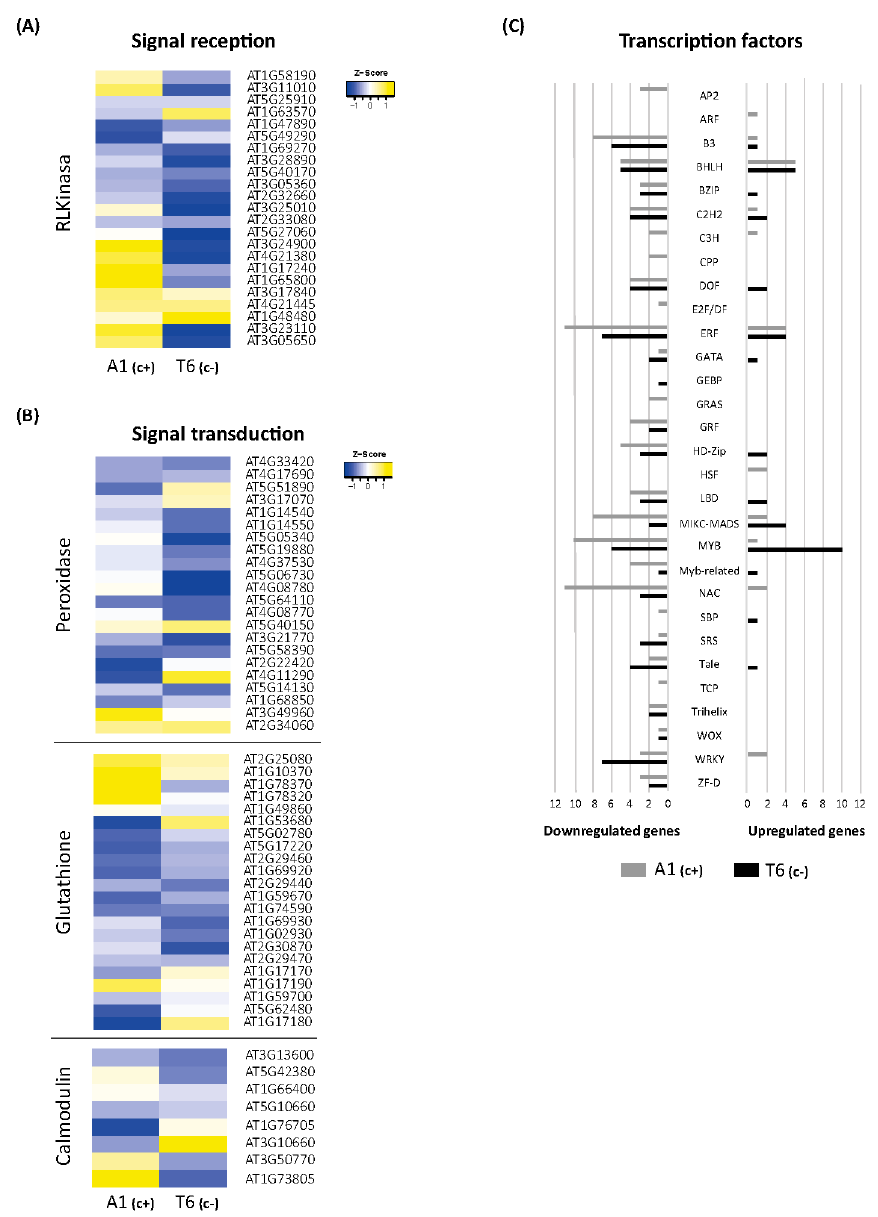
Figure 4. Differential expression of signal perception, transduction, and transcription factor (TF) genes involved in bicarbonate short responses. Heatmaps of DEGs from the receptor-like kinase gene family ( A ), and peroxidase, glutathione, and calmodulin gene families ( B ) in A1 (c+) and T6 (c+) , comparing bic vs. pH 5.9 exposure for 3 h. Yellow color represents upregulated genes while blue color represents downregulated genes. ( C ) Bar plot indicating the total number of DEGs upregulated (right) or downregulated (left) within each transcription factor family. Tolerant deme A1 (c+) is marked in grey, while sensitive deme T6 (c − ) is visualized in black color.